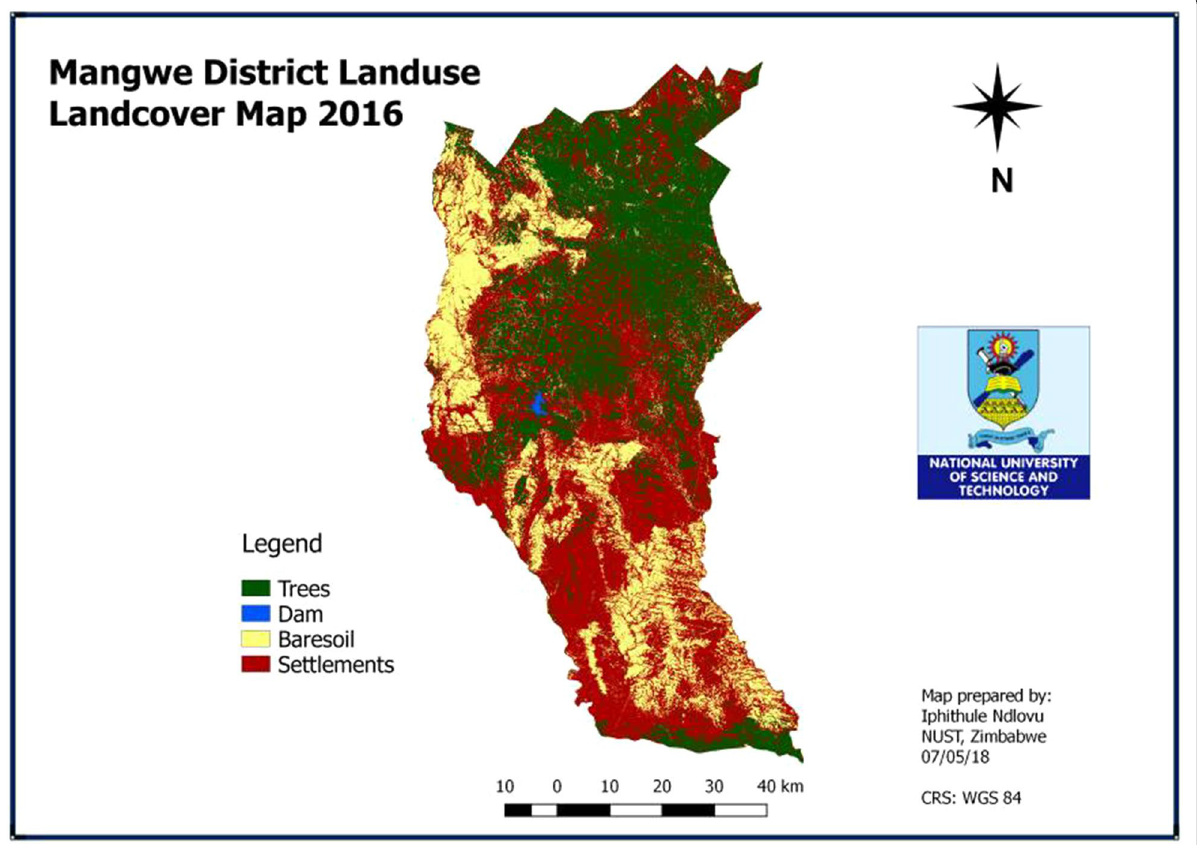
Fig. 3 LULC map 2016